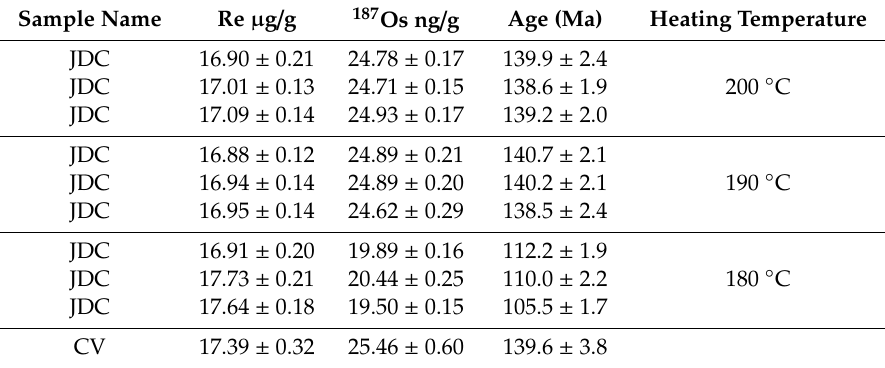
Table 6. Analytical results for molybdenite RM samples JDC at di ff erent